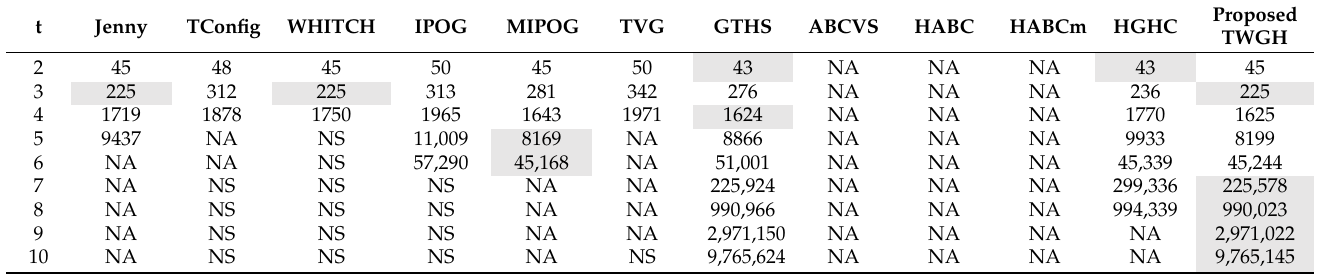
Table 2. CA (N; t, 10, 5) with t between 2 and 10.